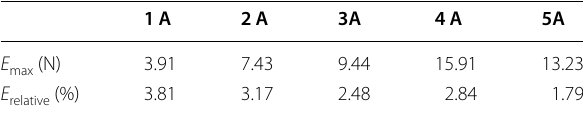
Table 1 The maximal variation E of the output force amplitude under different frequencies